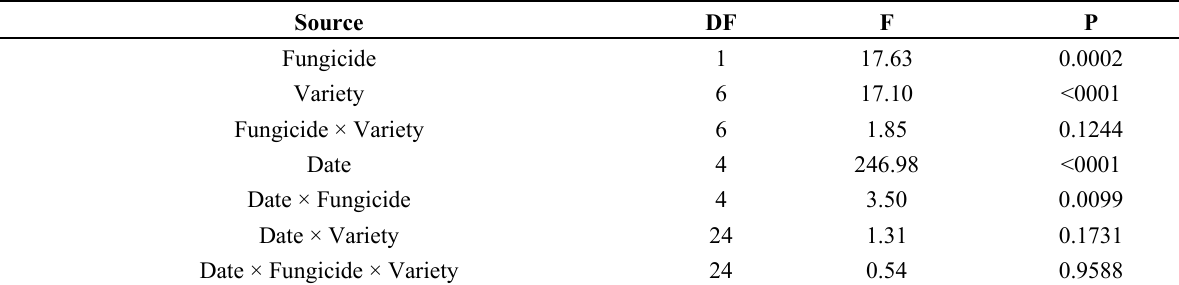
Table 3. Results of repeated-measures ANOVA performed against the leaf chlorophyll concentration (LCC) of barley.